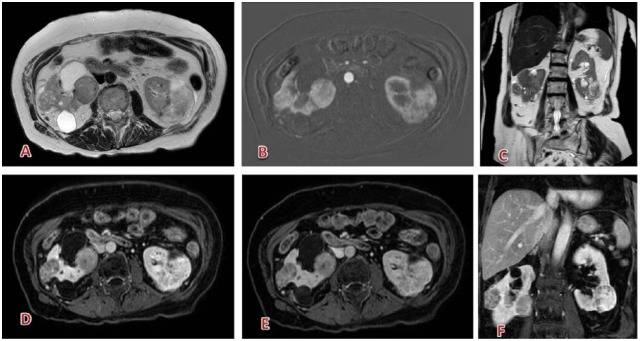
Multiple renal oncocytomas: (A, C) slightly hyperintense on T2, with hypointensity spots inside (central scar); (D, F, and B) moderate enhancement in arterial phase (subtraction); (E) progressive late washout (portal phase). Contrast agent: gadobutrol, 8 mL. Courtesy of Professor De Cobelli, Radiology Department, San Raffaele Scientific Institute, Milan.